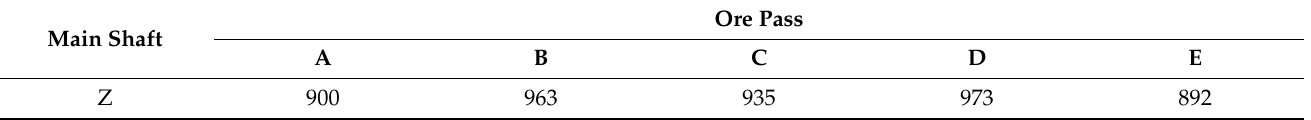
Table 6. Loaded travel time of the electric locomotive between ore pass and the main shaft/s (Units: s). Main Shaft